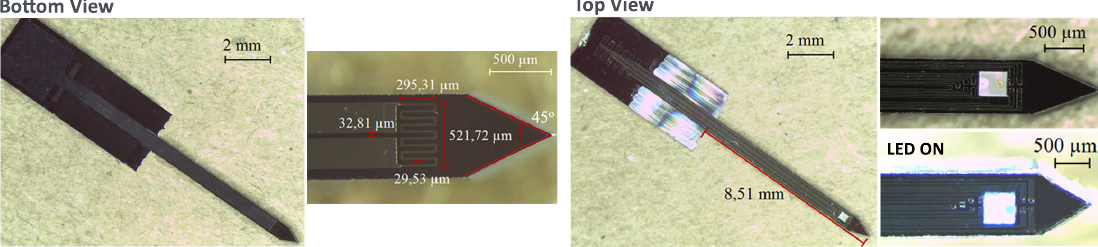
Figure 5. Results of the fabricated optrode integrating 10 Pt recording sites and commercial LED chip, and also a Pt RTD on its